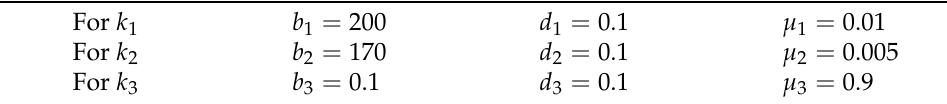
Table 3. Gains for a nonlinear PID controller.